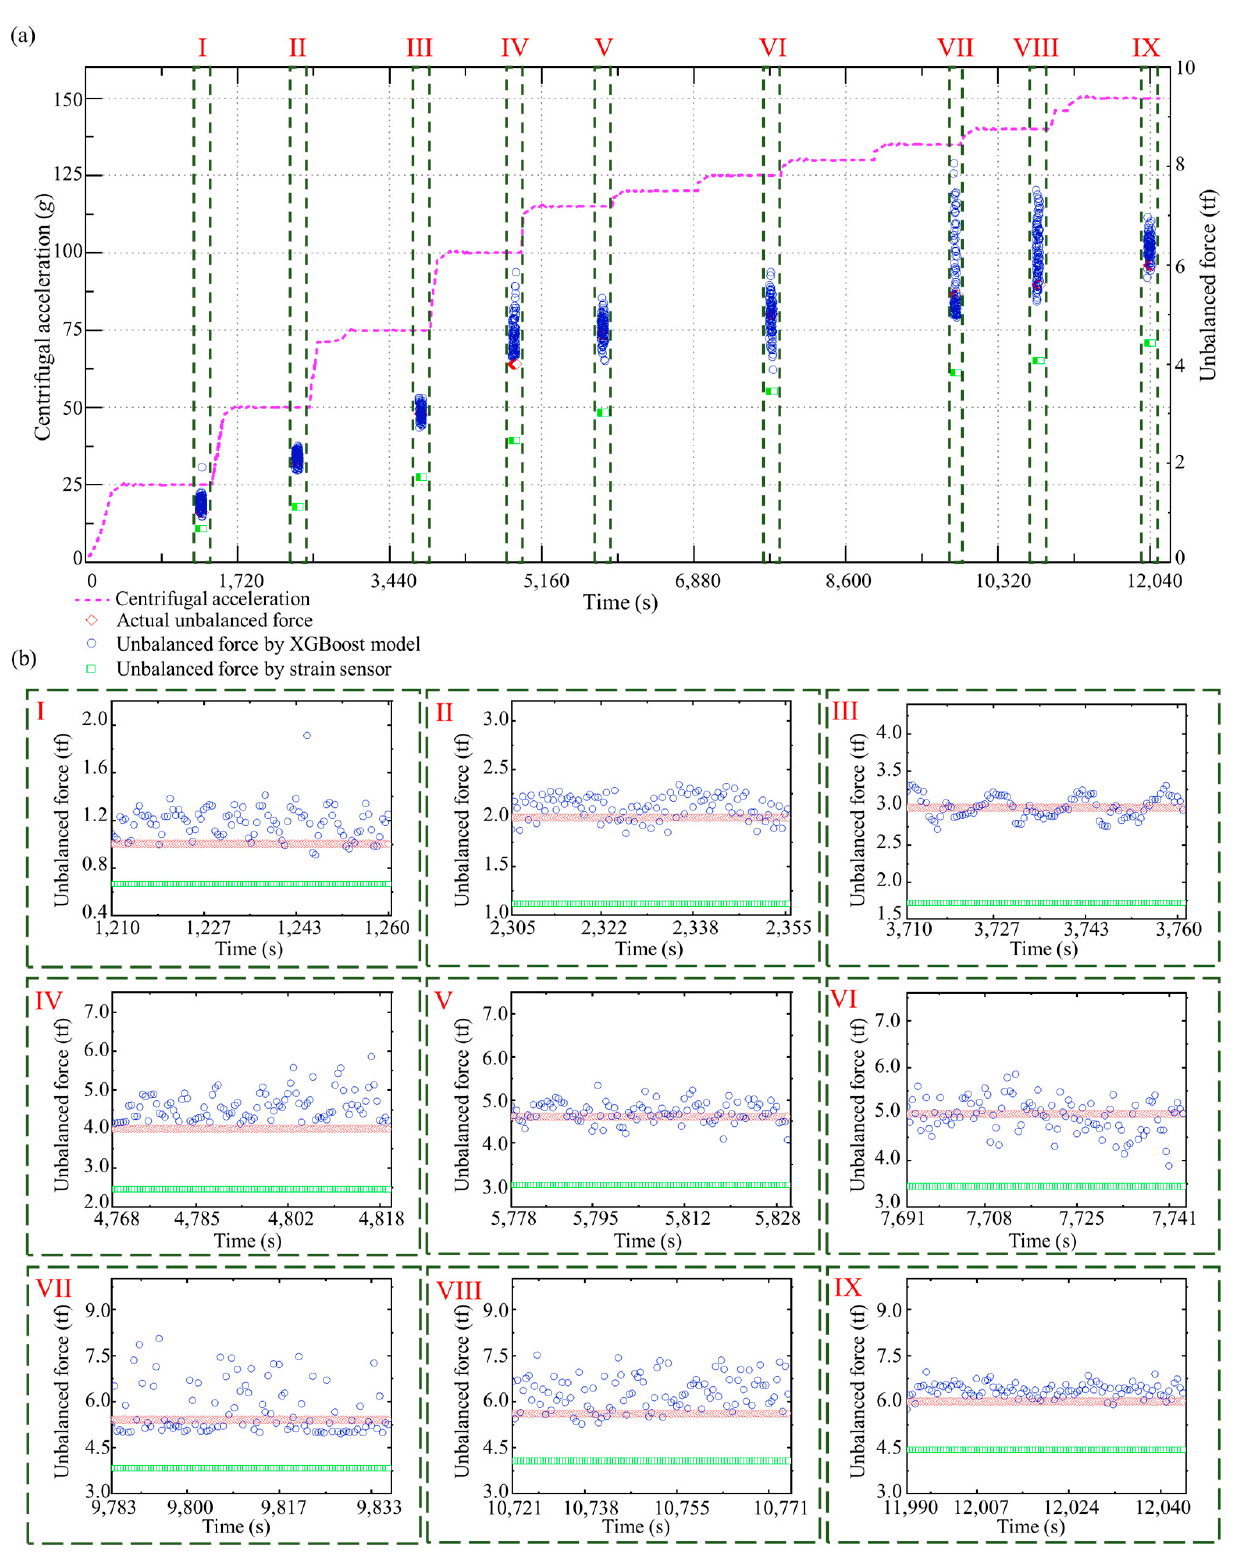
Figure 10. Unbalanced force identi fi cation results with the ResNet-Tweedie model. ( a ) The whole speed-up process. ( b ) Identi fi cation results during each centrifugal acceleration step.